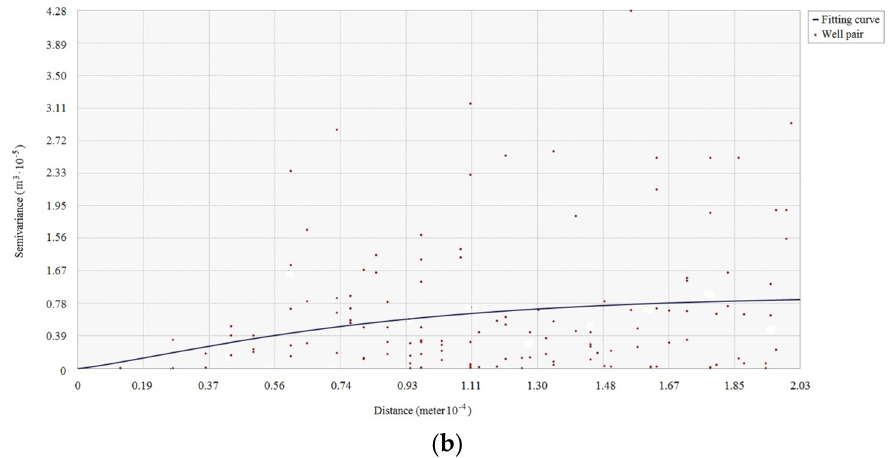
Figure 8. Semi-variogram clouds of ( a ) cumulative porosity; and ( b ) effective yield of the CHOPS data.